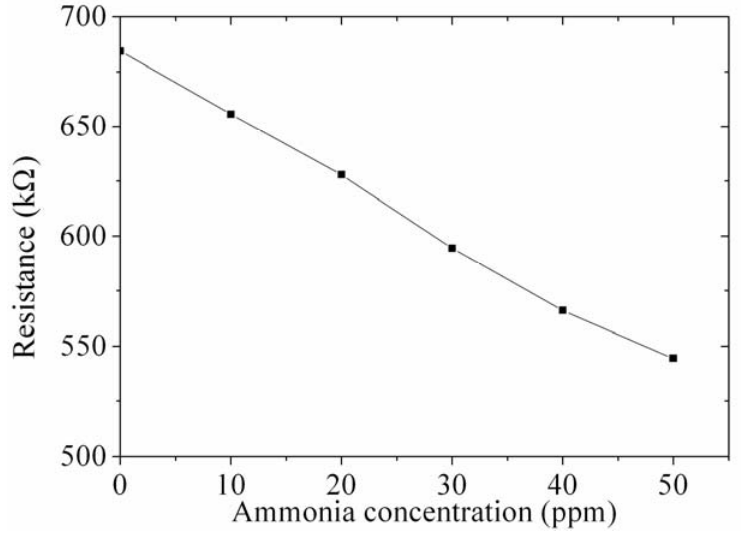
Figure 12. Measured results of the resistance for the ammonia